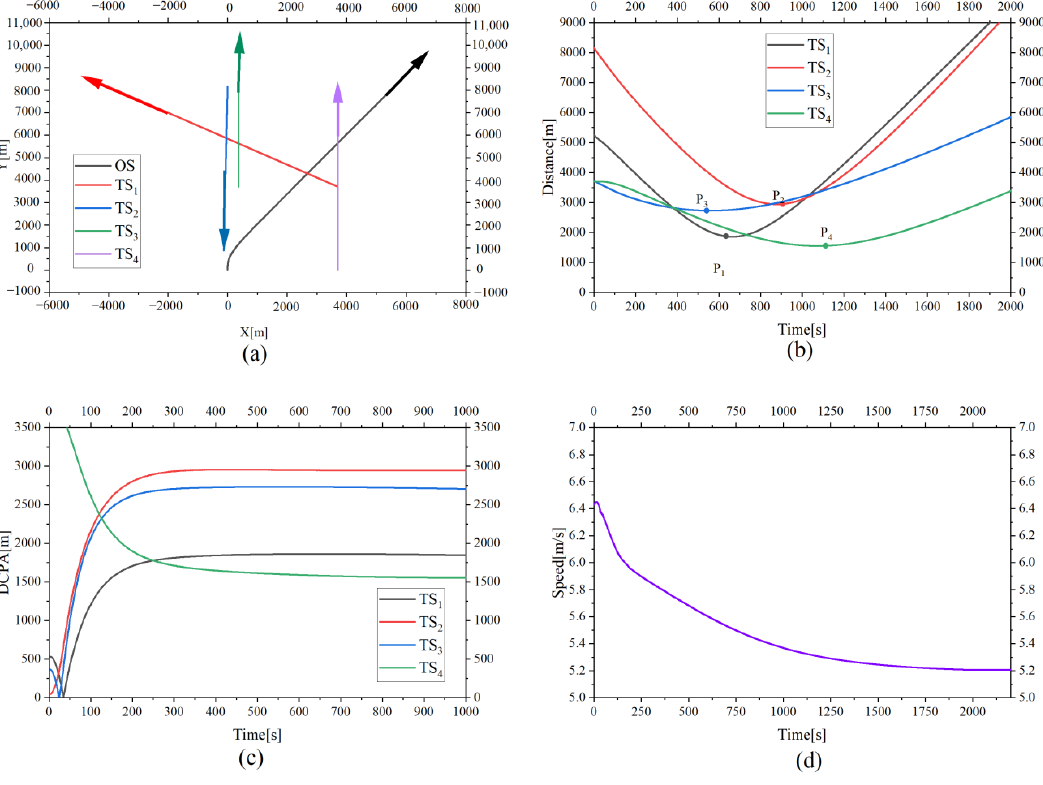
Figure 13. Simulation results of scenario 1: ( a ) Trajectory of OS and TSs; ( b ) Distance between OS and different TSs; ( c ) DCPA between OS and different TSs; ( d ) Speed of OS.